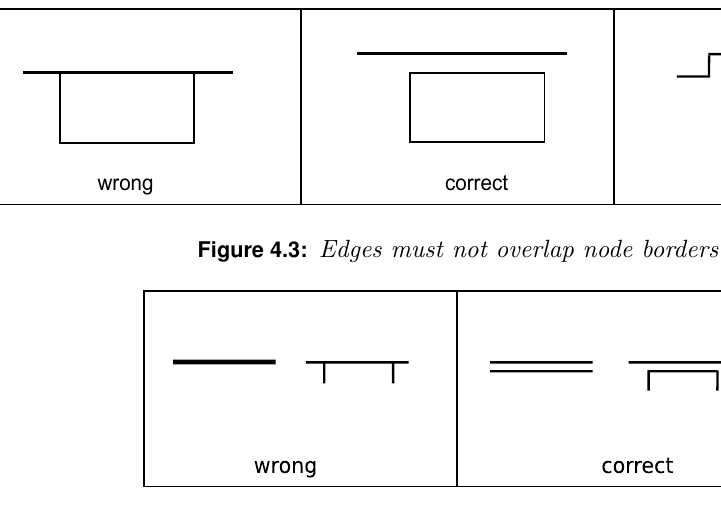
Figure 4.4: Edges must not overlap.